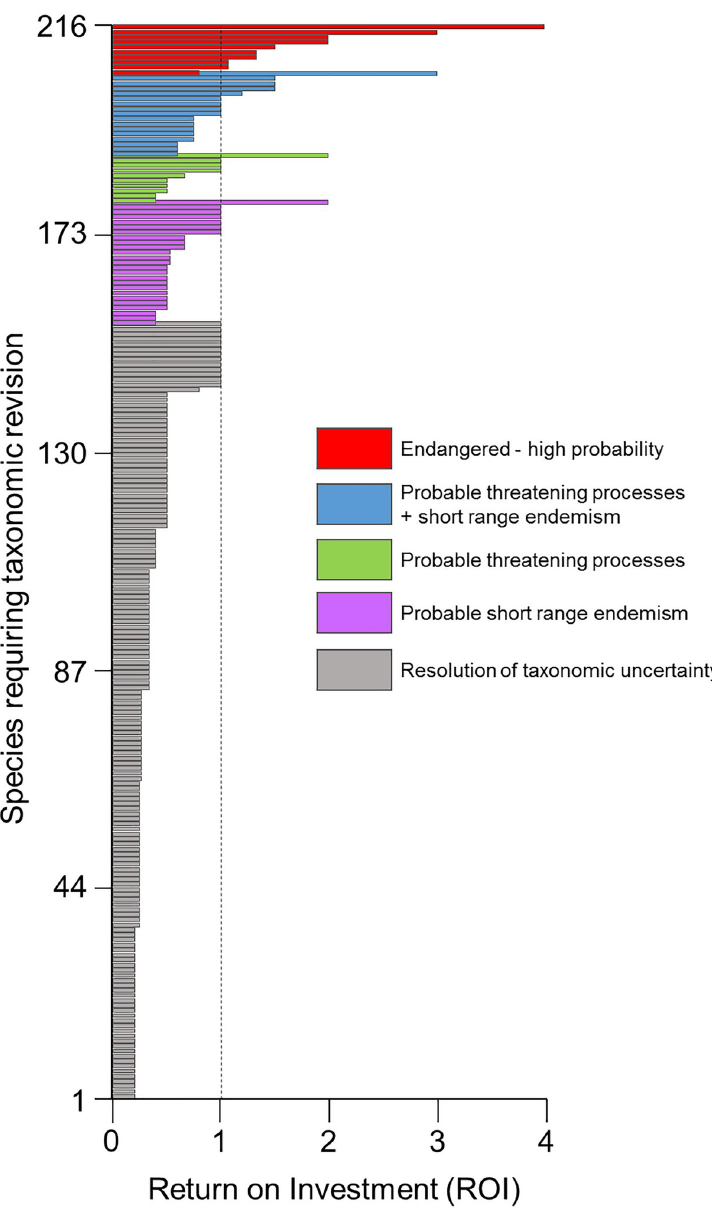
Fig 2. Estimated return on investment (ROI) for taxonomic research focused on conservation outcomes of Australian lizards and snakes. Each horizontal bar represents a species complex that experts assessed as needing taxonomic revision and that would likely lead to increased diversity. Species are colored according to the predicted conservation-related outcome of taxonomic revision. ROI is a cost-effectiveness metric (Methods), which estimates conservation concern of a species in relation to the research required to complete taxonomic revision. An ROI > 1 (depicted by the dashed line) indicates high conservation concern in comparison to research needed. Assessment data underlying figure available in S1